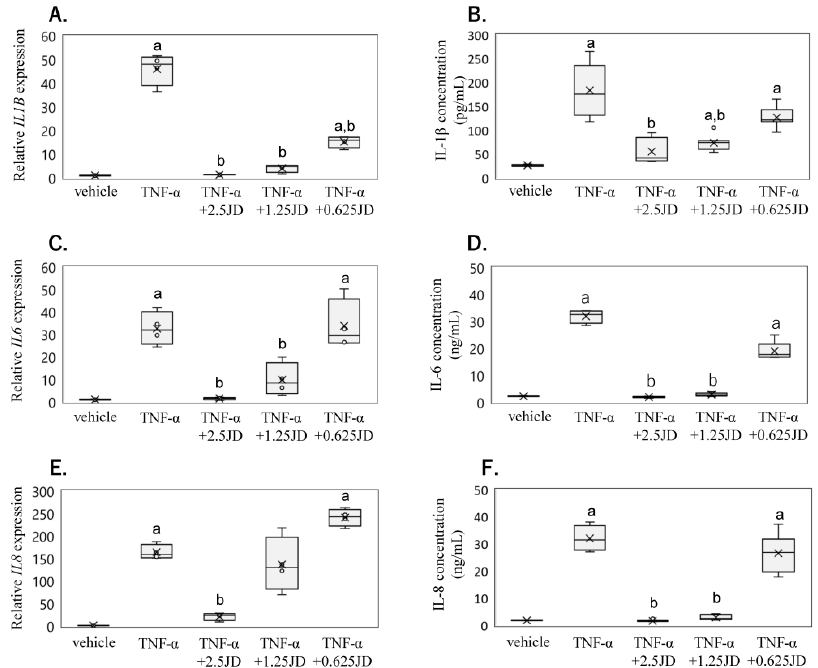
Figure 2. Effect of jietacin derivative on inflammatory cytokine expression and production in SW982. IL1B mRNA by qPCR ( A ) and IL- 1β protein concentration by ELISA ( B ). IL6 mRNA by qPCR ( C ) and IL-6 protein concentration by ELISA ( D ). IL8 mRNA by qPCR ( E ) and IL-8 protein concentration by ELISA ( F ). Synovial cell line SW982 stimulated with DMEM (vehicle), TNF- α , or TNF- α + jietacin derivative. a p < 0.05 compared to vehicle, b p < 0.05 compared to TNF- α .